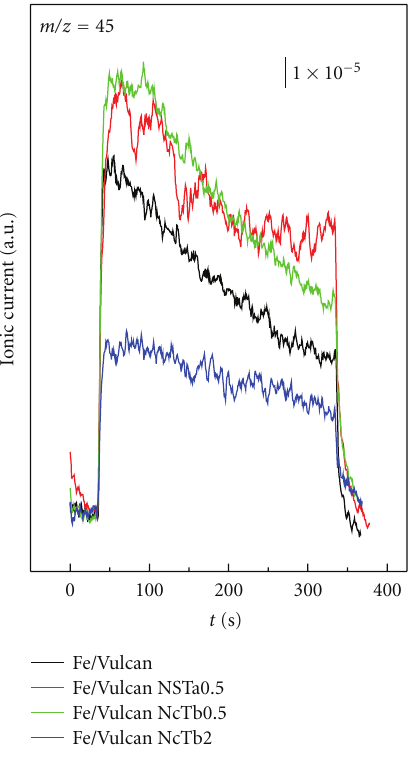
Figure 8: Corrected MSTs for CO 2 electroreduction in 0.5 M H 2 SO 4 on Fe/C catalysts ( E i = − 0 . 2 V, E f = − 1 . 8 versus Ag/